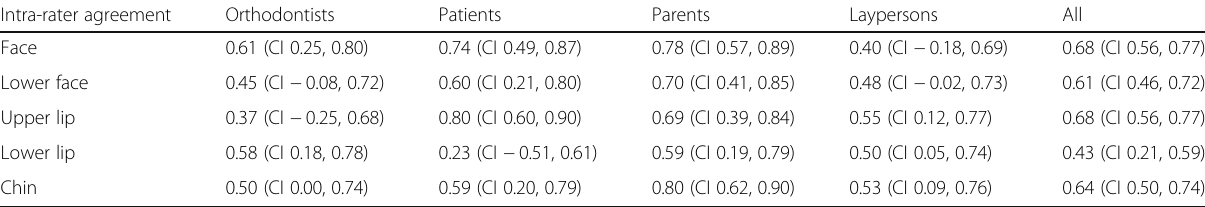
Table 1 Intra-rater agreement of repeated VAS ratings tested through the intraclass correlation coefficient (ICC, two-way random model, absolute agreement, results regarding average measures) Intra-rater